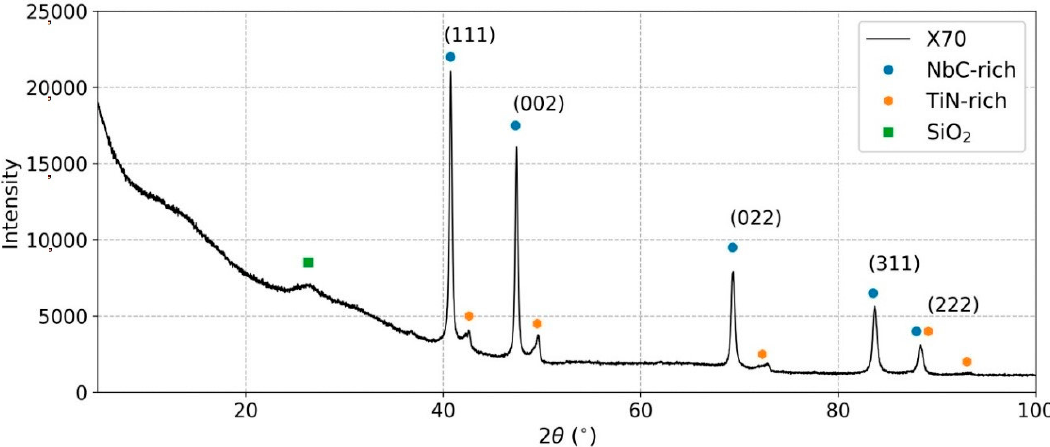
Figure 7. XRD pattern from TWX70 steel residue.